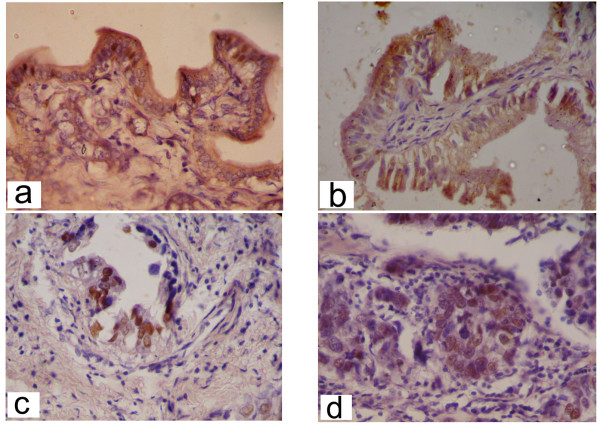
Photomicrograph showing both c-erbB-2 and p53 staining. (Figure 3a and b): apical granular and intense membranous c-erbb-2 positivity in adenoma gallbladder; (c and d): strong nuclear p53 positivity in well differentiated and poorly differentiated adenocarcinoma respectively.